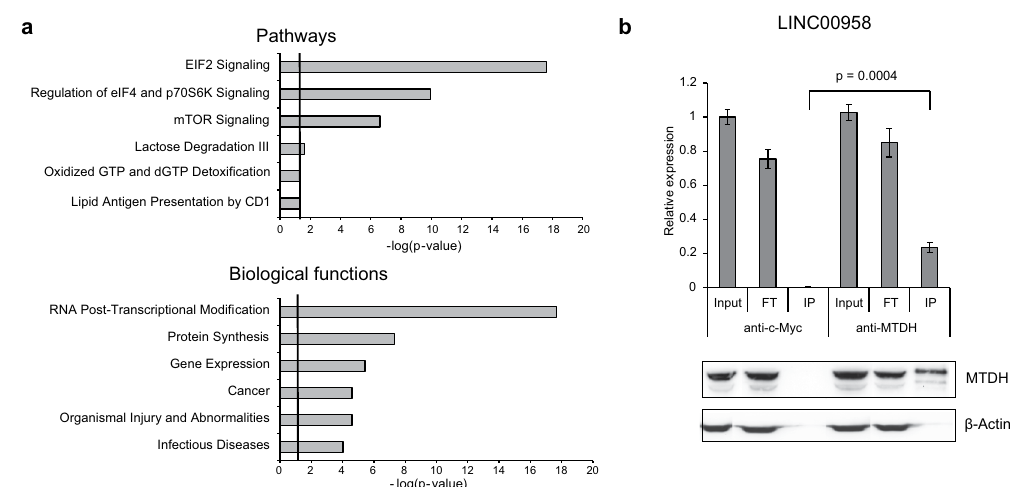
Figure 5. In vitro pull-down and mass spectrometry analysis identified LINC00958 interacting proteins. ( a ) Ingenuity Pathway Analysis. The most significantly pathways and biological functions associated with proteins binding biotin-tagged LINC00958. Only proteins demonstrating FCs ≥ 3, when comparing biotin- tagged LINC00958 to controls were included in the analysis (n = 330). Threshold value; p = 0.05. The analyses were based on knowledge from all species, all tissues, and all data sources. ( b ) Anti-MTDH RIP using FL3 cell lysates. Detection of endogenous LINC00958 was performed using RT-qPCR (upper panel). The RT- qPCR was performed in triplicates. The experiment was repeated twice and the result of one representative experiment ± SD is shown. IP with a c-Myc antibody was included as negative control. Western blotting analysis (lower panel) was used to evaluate IP of MTDH in the analyzed samples. Loading control input samples: β -actin. FT: flow-through and IP: